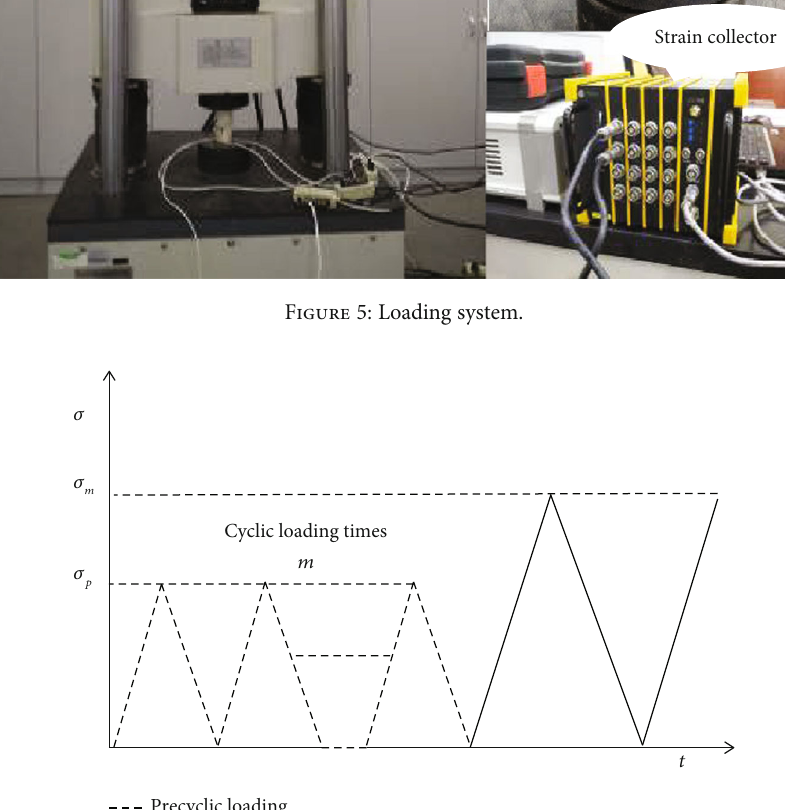
Figure 6: Cyclic loading